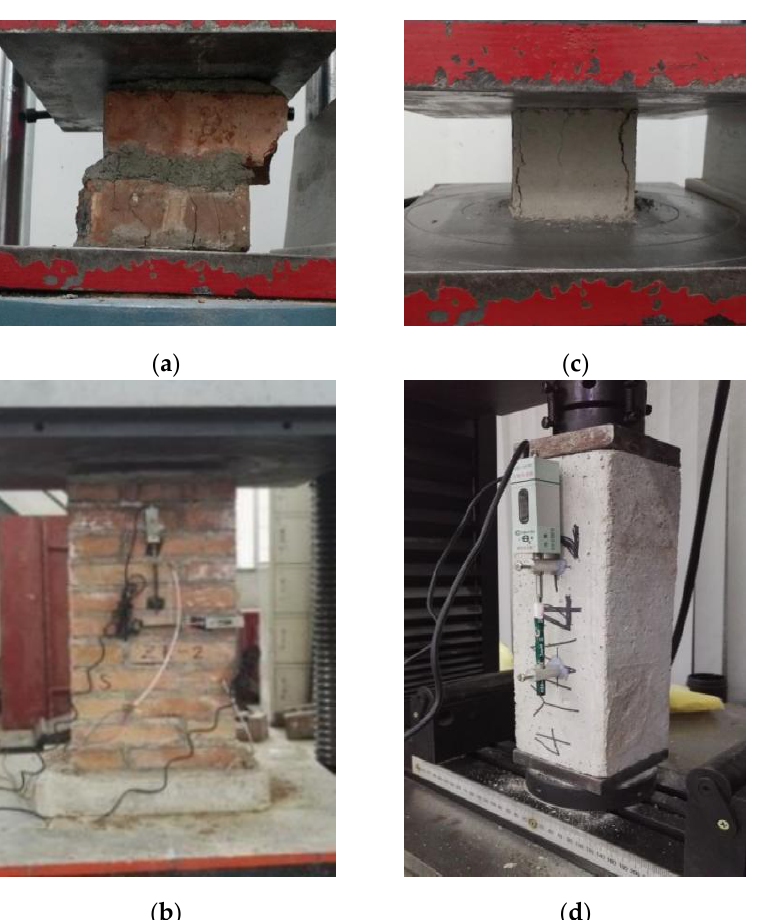
Figure 2. The testing of mechanical properties of brick ( a ), masonry ( b ) and mortar ( c , d ).